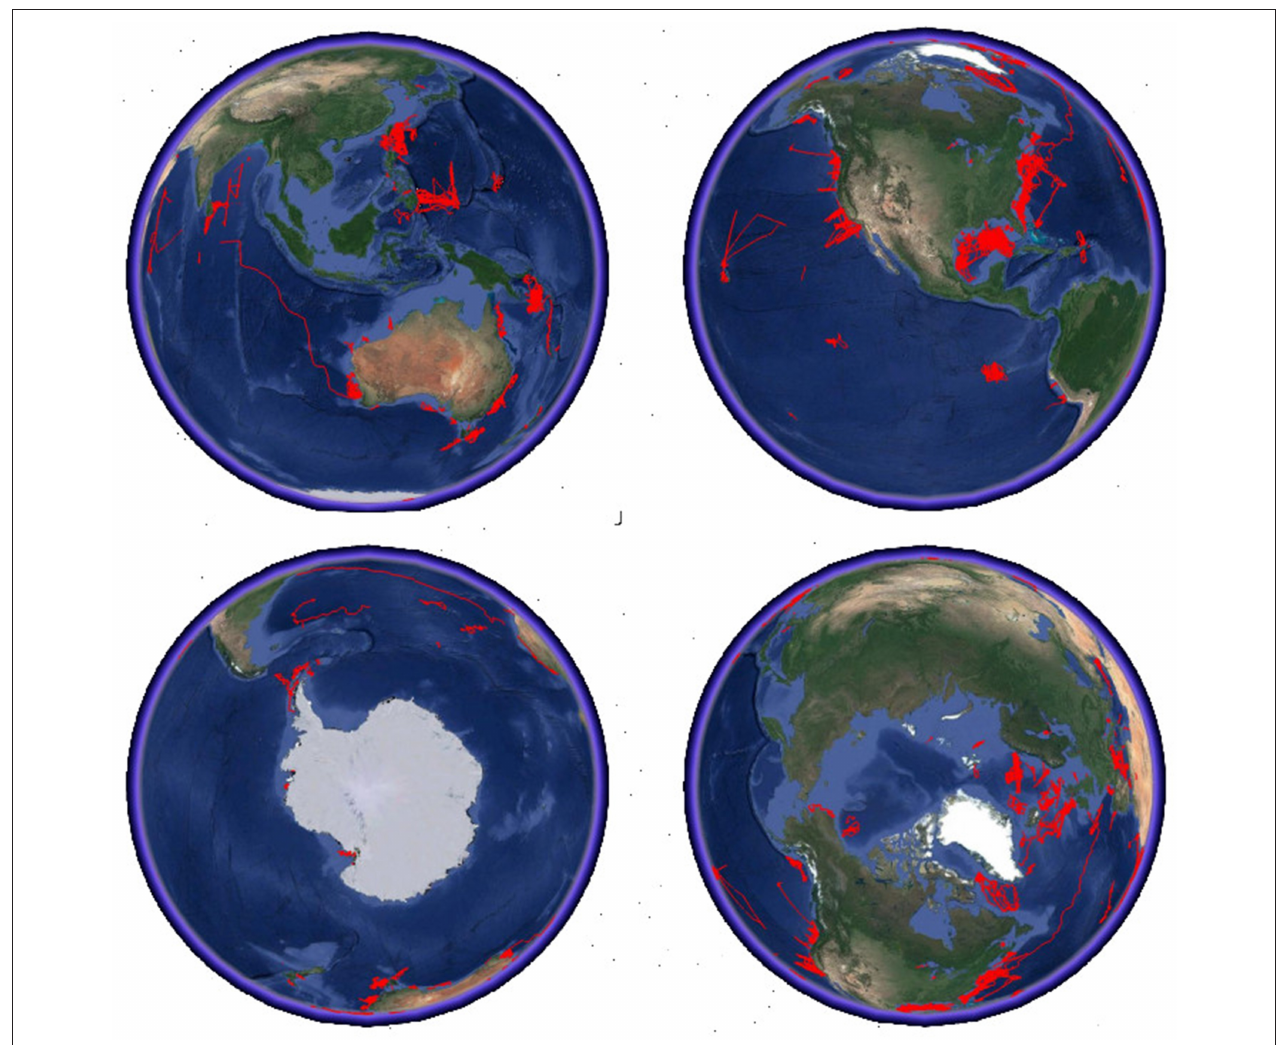
FIGURE 2 | Gliders tracks of past deployments until October 2018 (OceanObs’19 submissions), as can be viewed using google-earth from different locations.